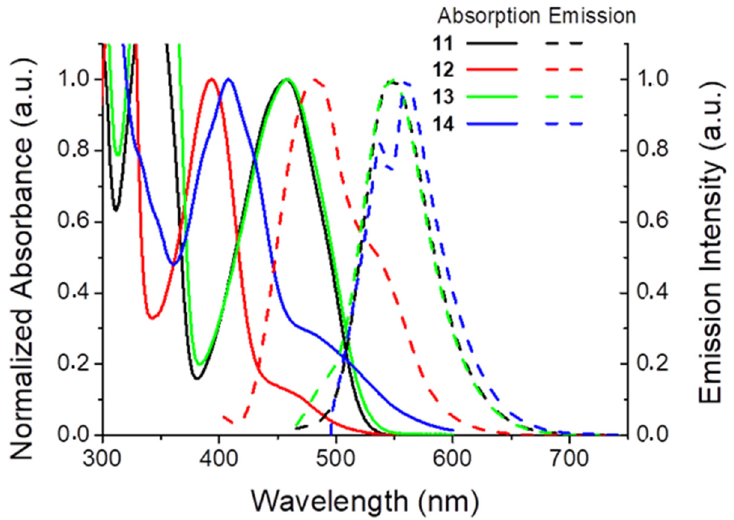
Figure 2. Normalized absorption and emission spectra DMSO (concentrations: 11 , 5 × 10 − 5 M; 12 , 1 × 10 − 5 M; 13 , 5 × 10 − 5 M; 14 , 1 × 10 − 4 M). Table 4. Absorption and emission data in DMSO.